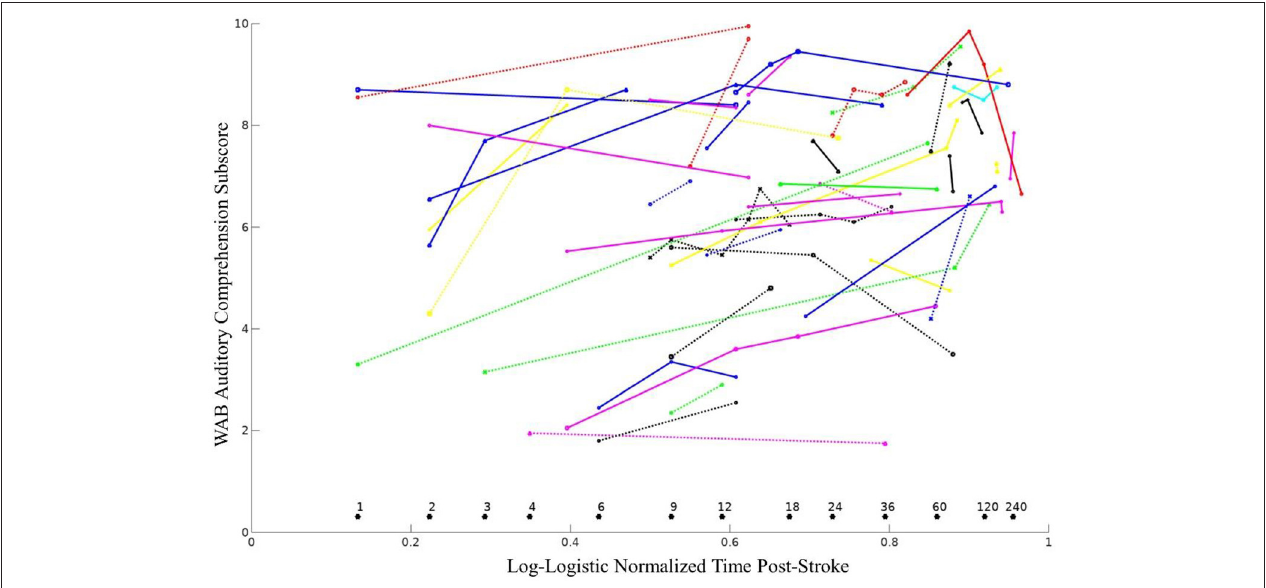
FIGURE 3 | WAB auditory comprehension subscores over time shown as distinct lines for all 44 individuals. Months post-stroke are reported above each asterisk (*). The log-logistic time compression provided an optimal transformation for examining recovery of auditory comprehension, using the following equation, where MPO represents months post-onset: f ( MPO ) = 1 1 + ( MPO 8 ) − 0.9